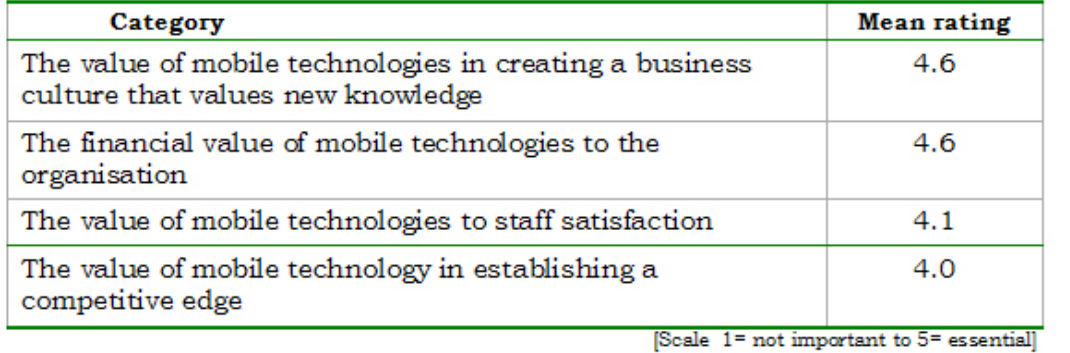
Table 1. Business benefits of m-technology use